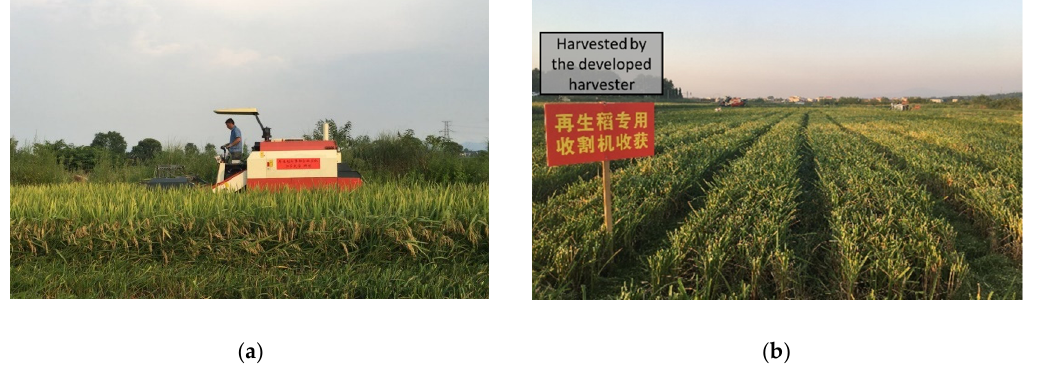
Figure 9. ( a ) Field test of the developed harvesting and ( b ) the stubble after harvesting. Table 3. The results of the comparative test.